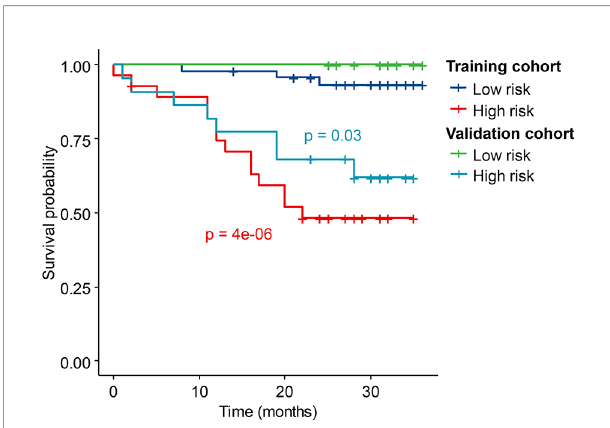
FIGURE 4 | Kaplan – Meier curves of the high- and low-risk patients strati fi ed by the combined model in the training cohort and validation